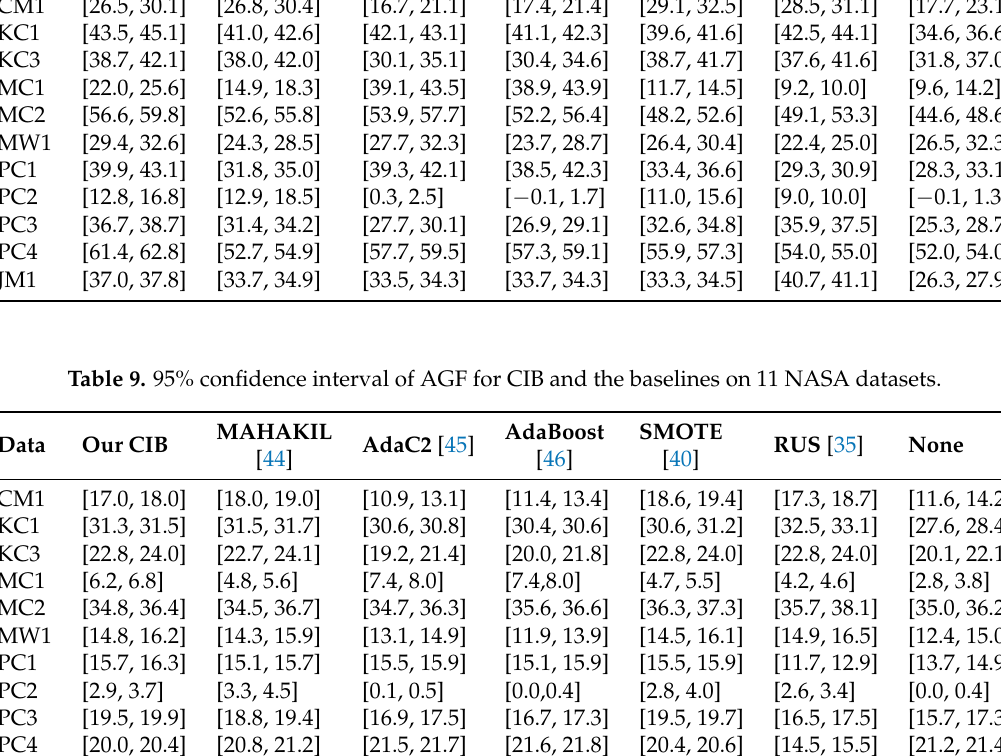
Table 8. 95% confidence interval of F 1 for CIB and the baselines on 11 NASA datasets. Data